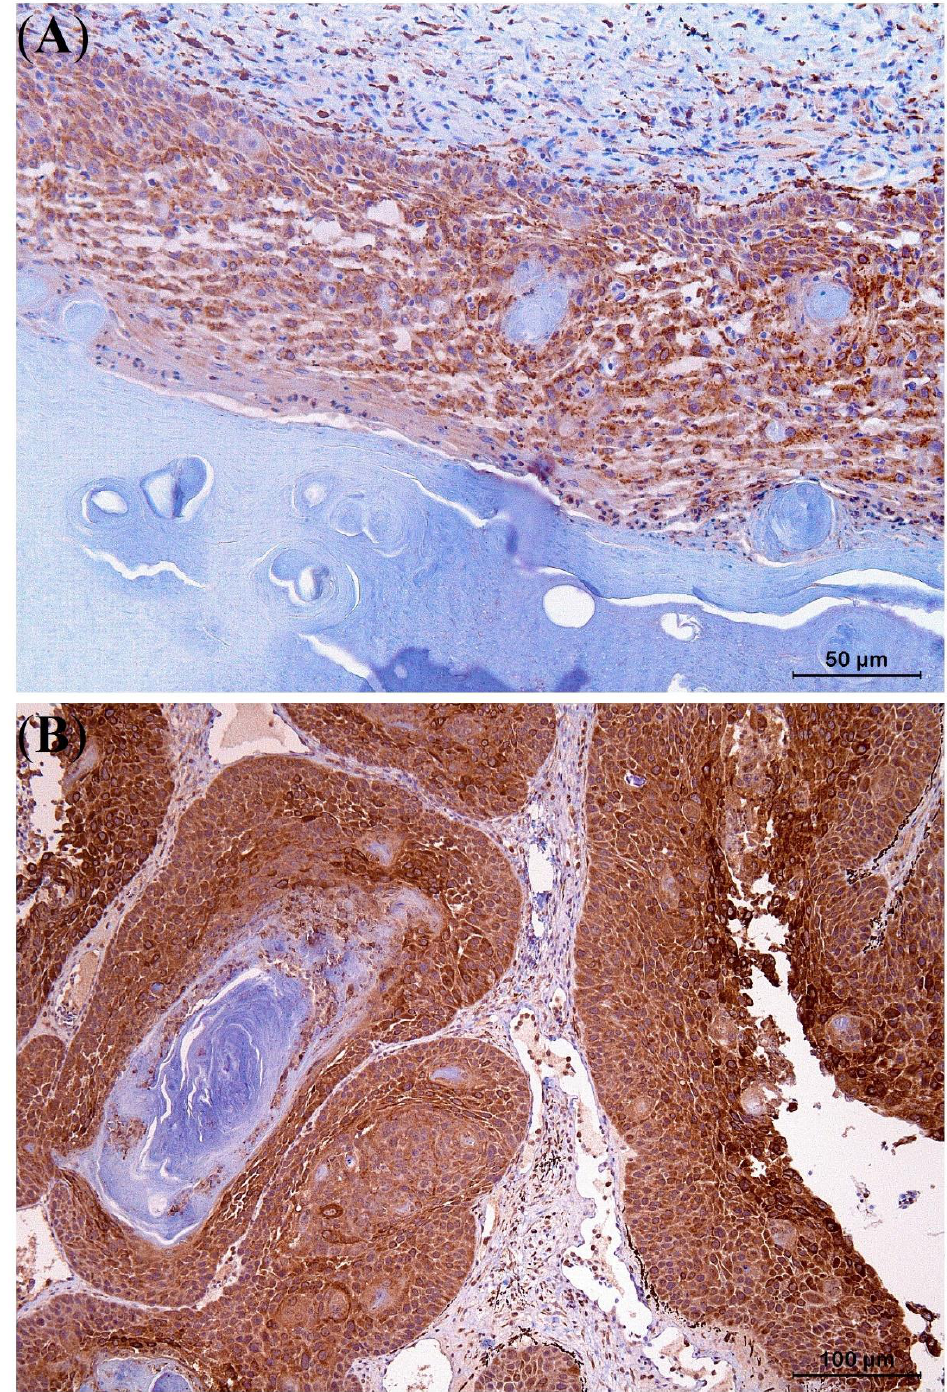
Figure 8. Moderate intracytoplasmic COX-2 staining of a keratoacanthoma (KA) from the lateral body wall of a panther chameleon ( Furcifer pardalis ) ( A ). Strong intracytoplasmic COX-2 staining of the squamous cell carcinoma arising at the periphery of a KA with malignant transformation, obtained from the eyelid of a panther chameleon ( B ).